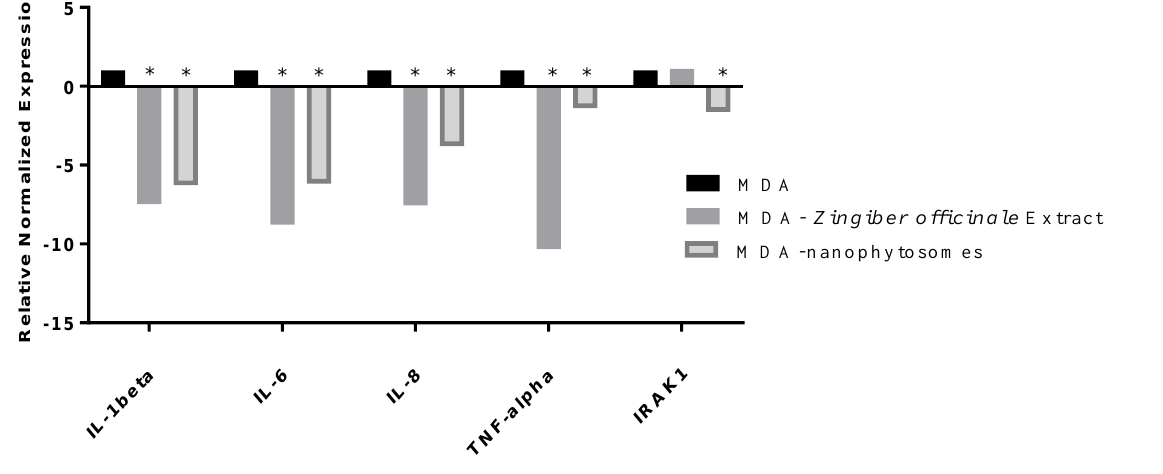
Figure 6. Effect of Zingiber officinale extract, 6-gingerol, and 6-gingerol-loaded PEGylated nanophy- tosomes on wound healing of human periodontal ligament fibroblasts cells compared with control (untreated cells). ***: p < 0.001. 0